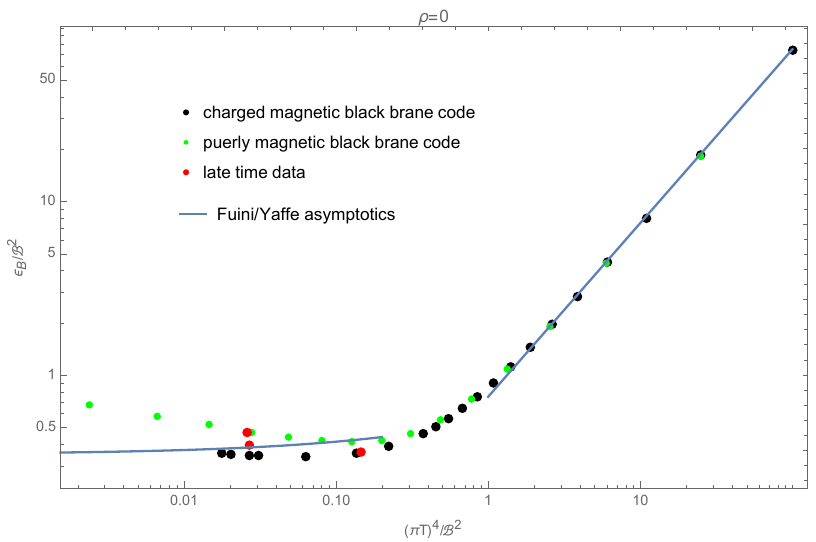
Figure 5 . Physically distinct (uncharged) magnetic black branes are uniquely labeled by dimen- sionless ratios, (cid:15) B = B 2 , ( (cid:25)T ) 4 = B 2 [62]. This plot is a slice of (cid:12)gure 4 at (cid:26) 4 = 3 = B 2 = 0. In this (cid:12)gure, at vanishing charge density, the energy density and temperature are displayed normalized to the magnetic (cid:12)eld. There is one unique curve on which all (uncharged) magnetic black brane solutions lie. Deviations of the data from this one curve is due to numerical errors, which increase with B . Red dots (late time data from our fully dynamical evolution) are at B = 1 ; 2 ; 3 increasing from right to left. Black and green dots indicate data from equilibrium calculations, both using the shooting method, however, the two codes use slightly di(cid:11)erent horizon/boundary cuto(cid:11)s, di(cid:11)erent numerical working precision and di(cid:11)erent number of orders in the near-horizon expansion.